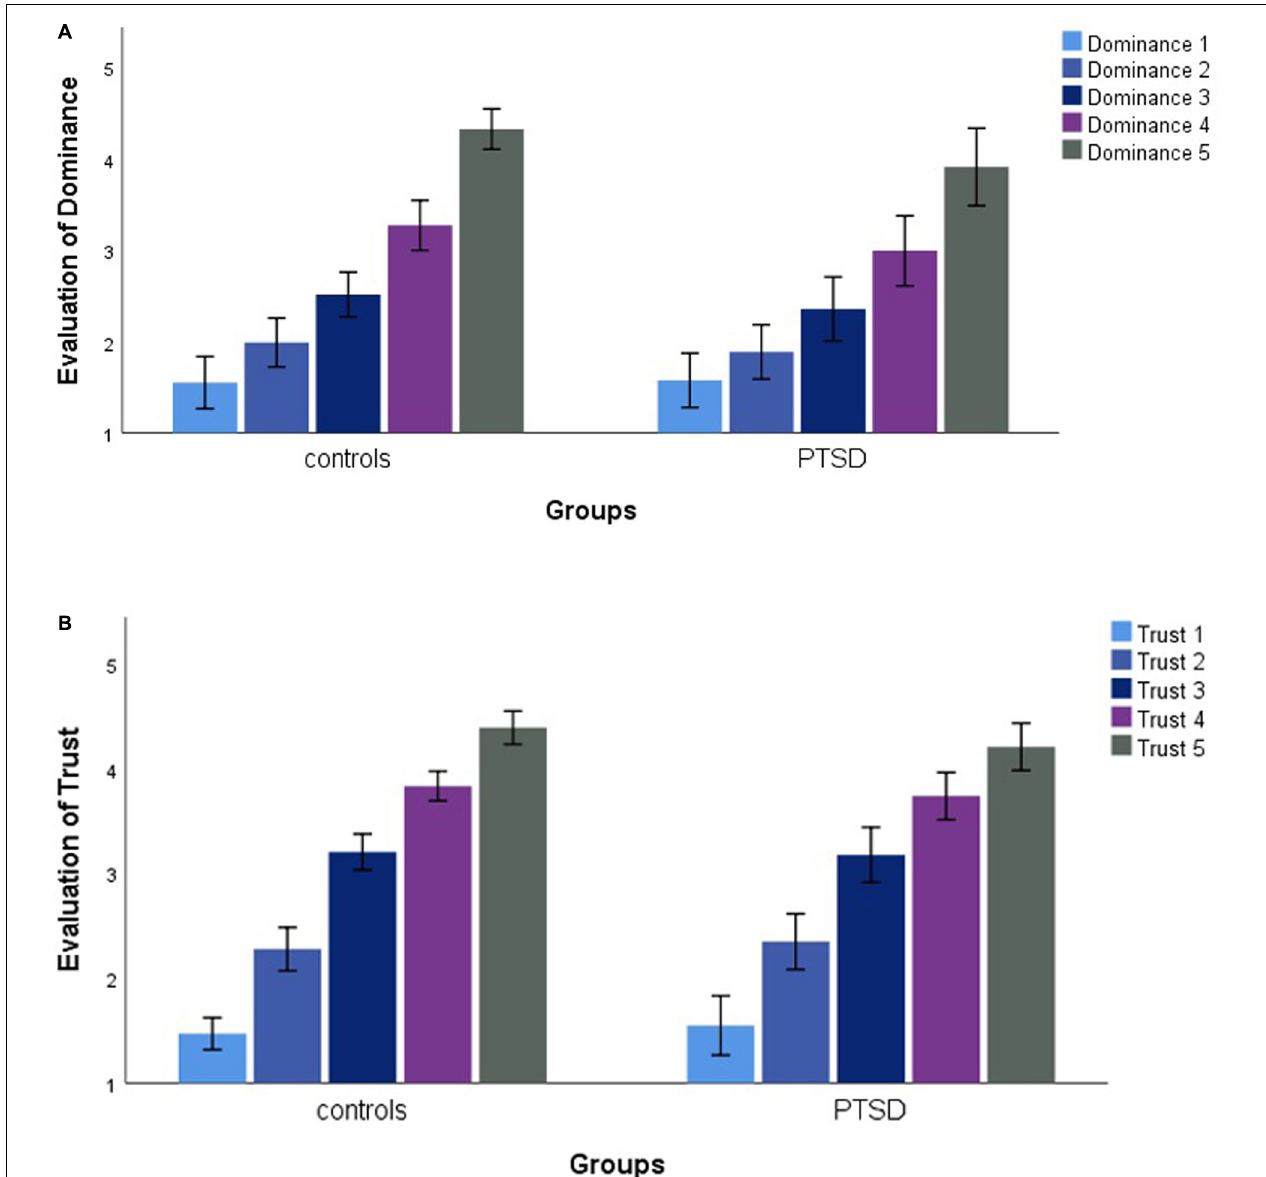
FIGURE 2 | Mean evaluation of avatars regarding dominance (Dominance = 1–5) (A) and trustworthiness (Trust = 1–5) (B) for each group (IPV-PTSD vs non-PTSD controls).